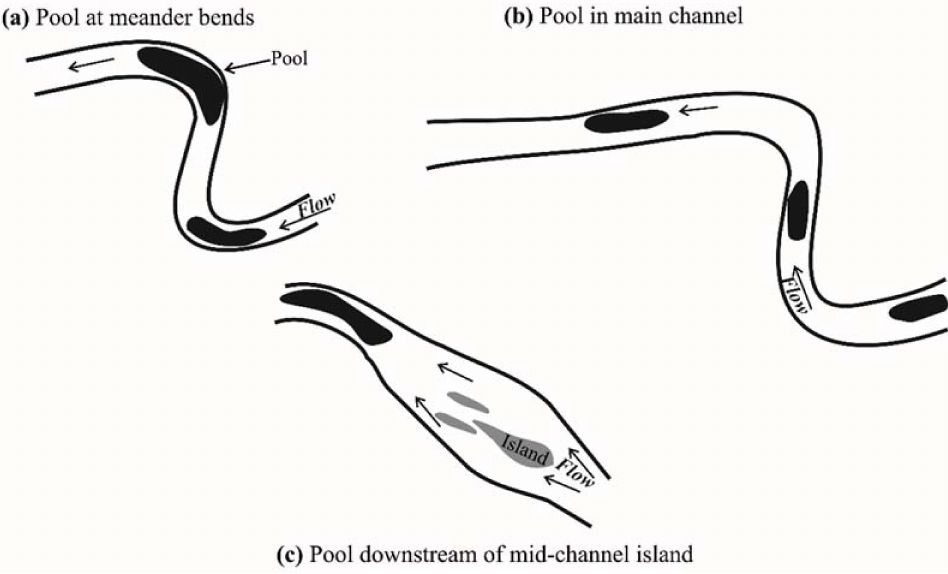
Figure 5. Main deep pool types in the Iguaçu River and tributaries downstream of the Salto Caxias Dam, upstream of the Iguaçu Falls in Iguaçu National Park. Adapted from Halls et al.